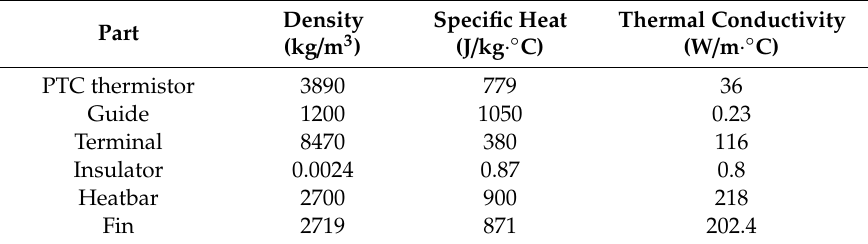
Table 4. Thermal properties of the